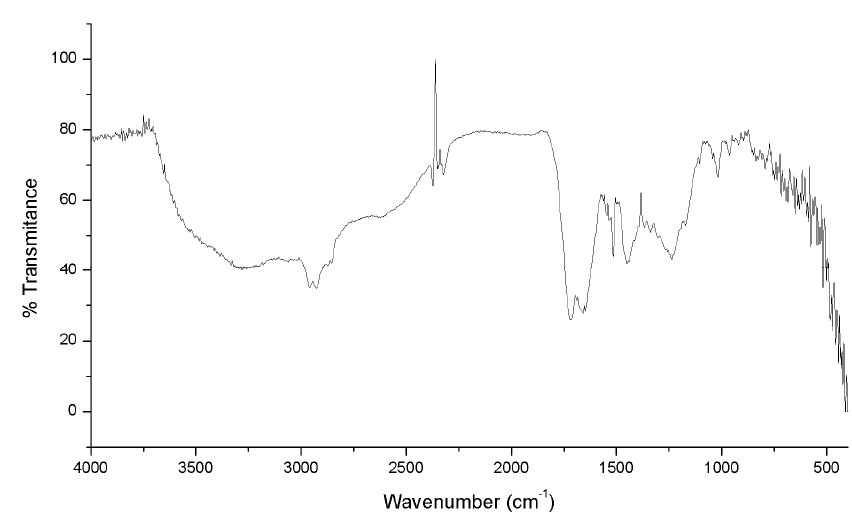
Figure 6. Fourier-transform infrared spectroscopy (FTIR) spectrum for biosurfactant obtained from L. acidophilus NCIM 2903.